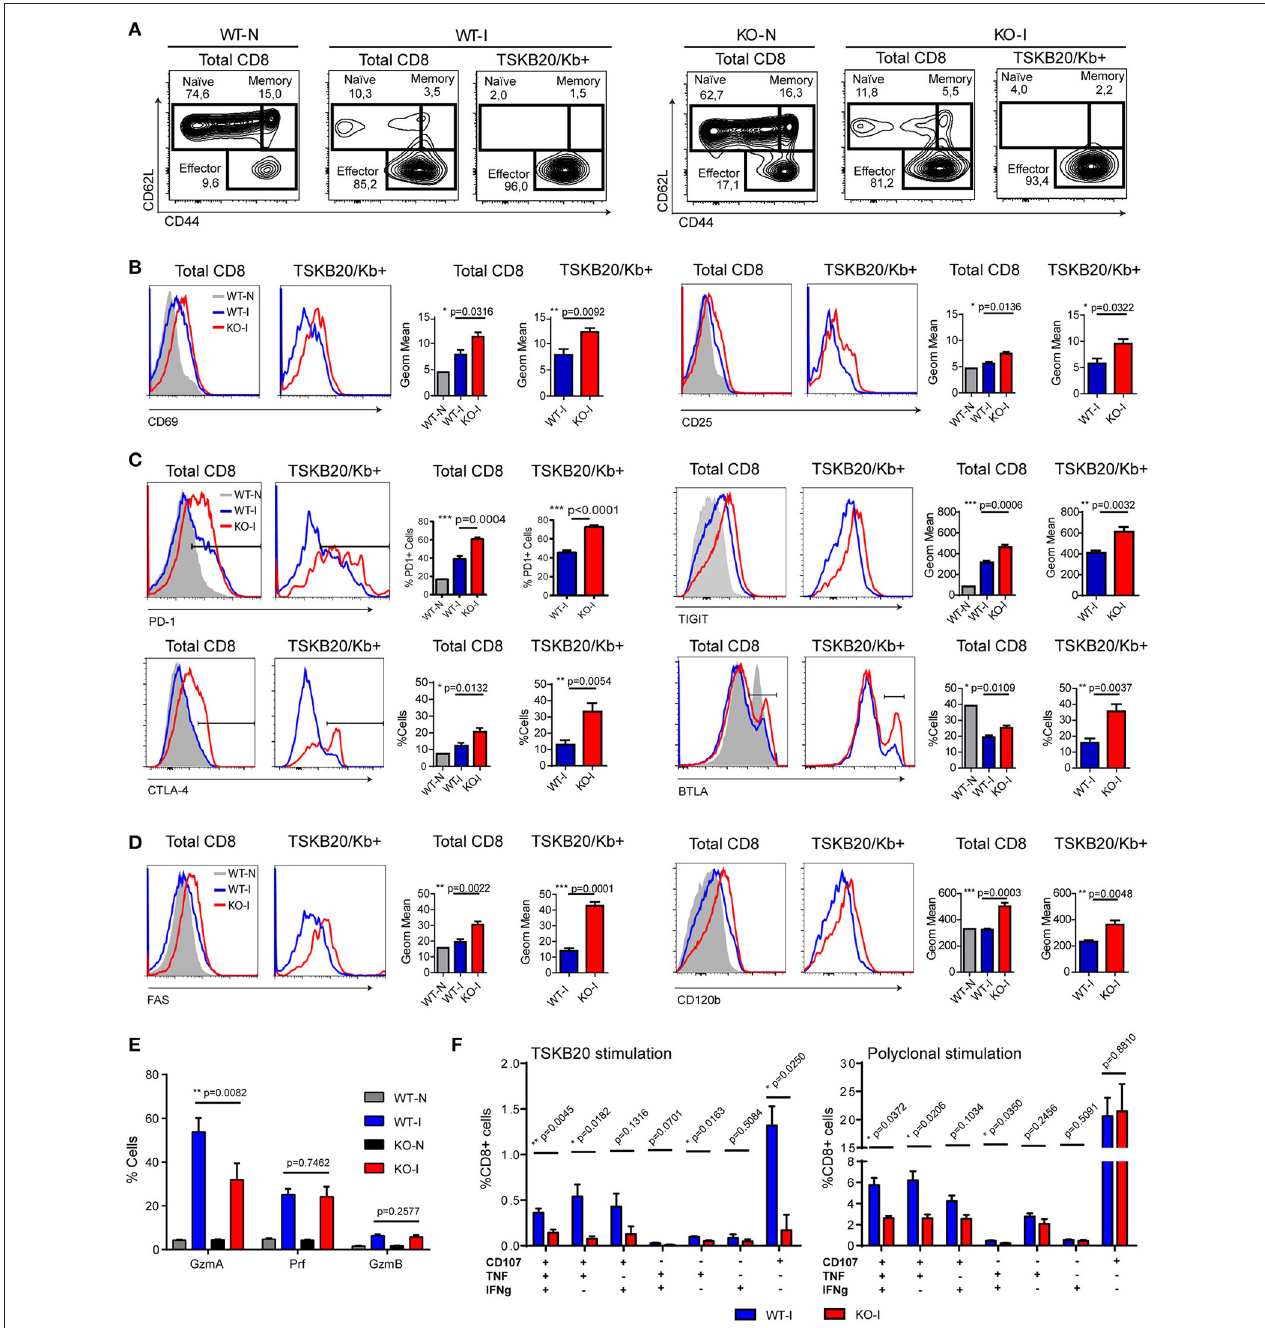
FIGURE 4 | CD8 + T cells from T. cruzi infected IL-17RA KO mice show phenotypic and functional features compatible with exhausted cells. Representative flow cytometry data that show the phenotype of total and TSKB20/Kb + CD8 + T cells from the spleen of infected WT (WT-I) and IL-17RA (KO-I) mice (22 dpi). Stainings of non-infected WT (WT-N) and KO (KO-N) mice are showed in plots or gray tinted histograms for comparison. (A) Plots of CD62L vs. CD44 expression. Gates indicate the frequency of naïve, memory and effector subsets. (B–D) Representative histograms and statistical analysis of the geometric mean of expression or percentage of cells that express activation markers (B) , inhibitory receptors (C) , and death receptors (D) in total and TSKB20/Kb + CD8 + T cells from the spleen of infected WT (WT-I) and IL-17RA (KO-I) mice (22 dpi). Data in statistical analysis (B–D) are presented as mean ± SD, N = 4 − 6 mice. (E) Percentage of CD8 + T cells from the spleen of non-infected (N) and 22-day infected (I) WT and KO mice expressing Granzyme A (GzmA), Perforin (Prf) or Granzime B (GzmB) after 5h of PMA/Ionomycin stimulation. Data shown as mean ± SD , N = 2 − 5 mice. (F) Percentage of CD8 + T cells from the spleen of 22-day infected WT and KO mice that exhibit different combinations of effector functions including CD107a mobilization and/or IFN γ and/or TNF production upon 5h of the indicated stimulation. Data shown as mean ± SD , N = 5 mice. Data were background subtracted. All P values were calculated using two-tailed T test. Data are representative of two-three independent experiments.